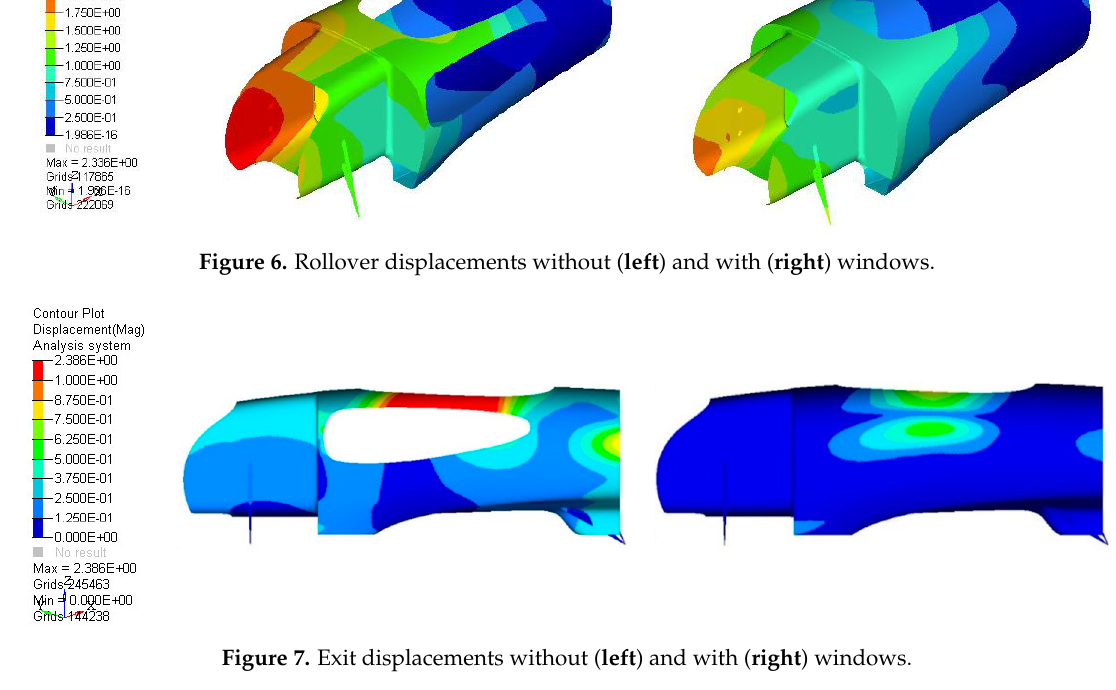
Figure 9. Free-size-optimization of honeycomb thickness: Top ( left ) and bottom ( right ) view.